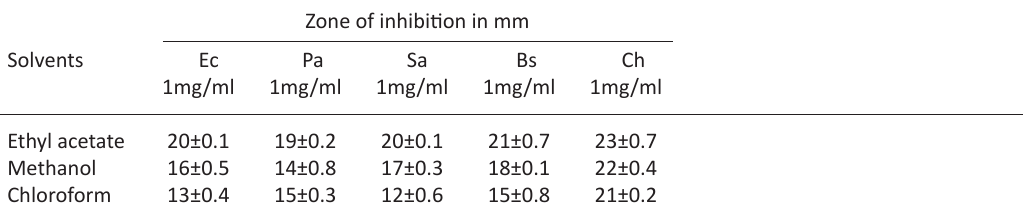
Table 3. Bioactivity of crude extracts of A.flavus against four bacterial pathogens